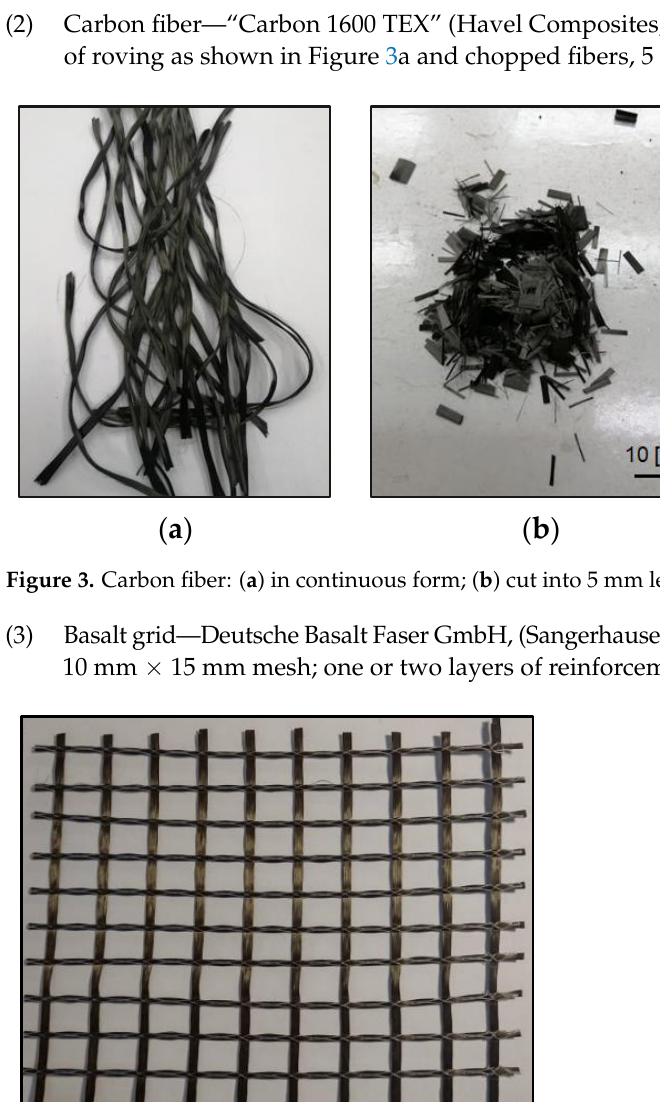
Figure 2. Type E glass fiber: ( a ) continuous; ( b ) 4.5 mm length; ( c ) 12 mm length .